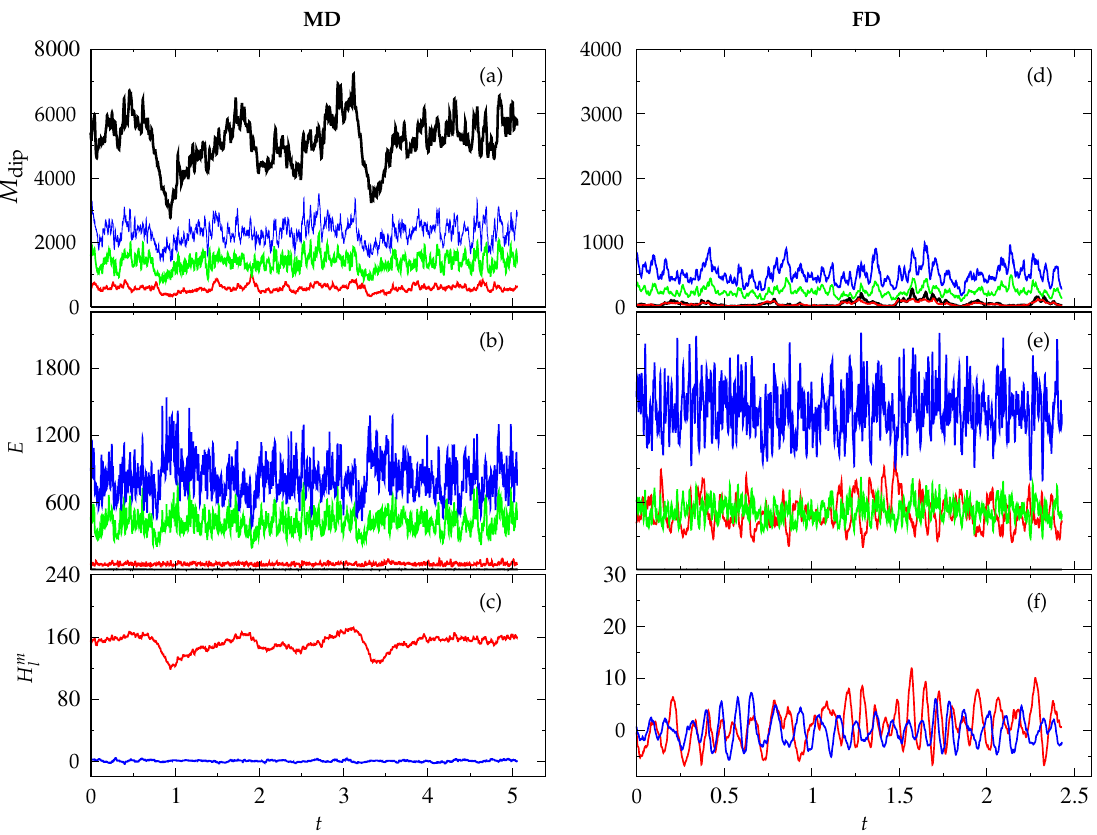
Figure 5. Chaotic dynamo attractors at identical parameter values—a Mean Dipolar (MD) dynamo (left column ( a – c )) and a Fluctuating Dipolar (FD) dynamo (right column ( d – f )) both at η = 0.5, 10 5 , τ = 2 10 4 , P = 0.75 and P m = 1.5. Panels ( a , d ) show time series of magnetic dipolar R = 8.2 × × energy densities and panels ( b , e ) show kinetic energy densities. The component X p is shown by solid black line, while X t , (cid:101) X p , and (cid:101) X t are shown by red, green and blue lines, respectively. X stands for either and the axial quadrupolar H 0 coefficients at midshell M or E . Panels ( c , f ) show the axial dipolar H 0 2 1 r = ( r i + r o ) /2 by red and blue lines, respectively. Note the very different ordinate scales between panels ( a , c , d , f ). The ordinate scales of panels ( b , e ) are identical. (Colour